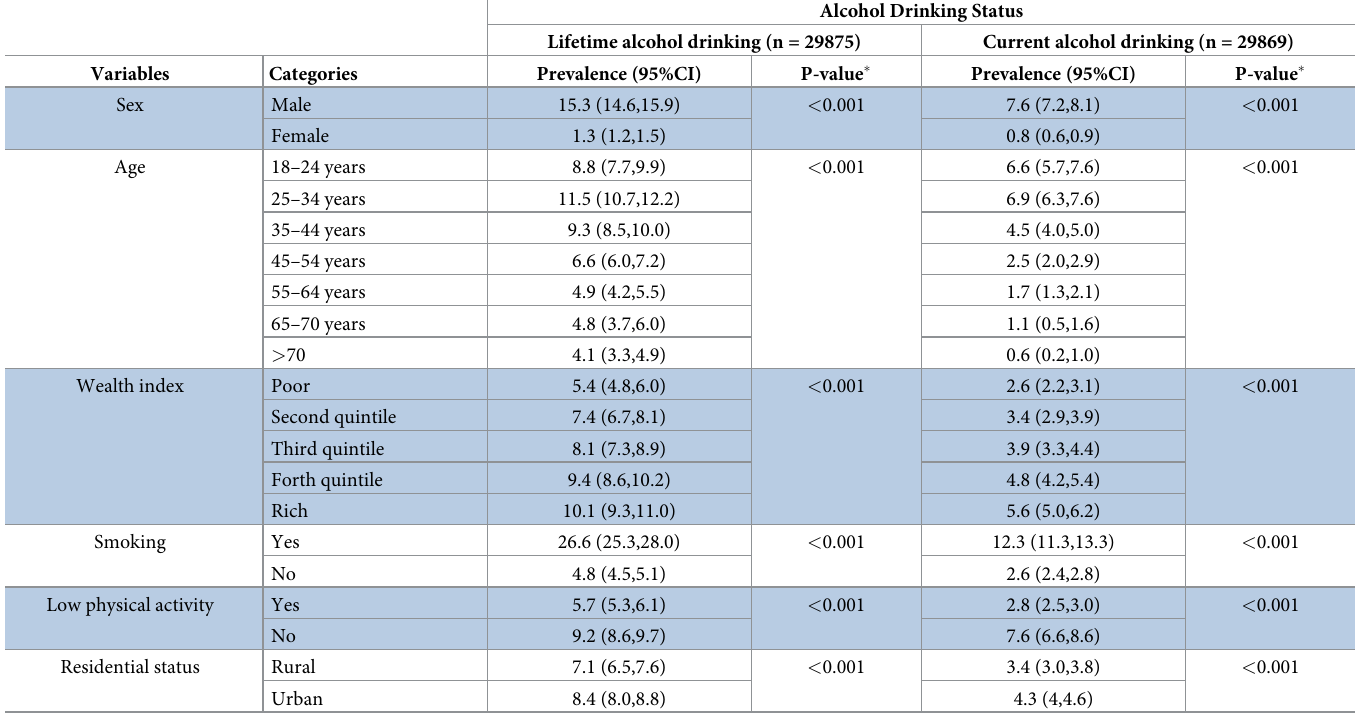
Table 1. The alcohol drinking status and demographic characteristics in Iran, 2016 (National